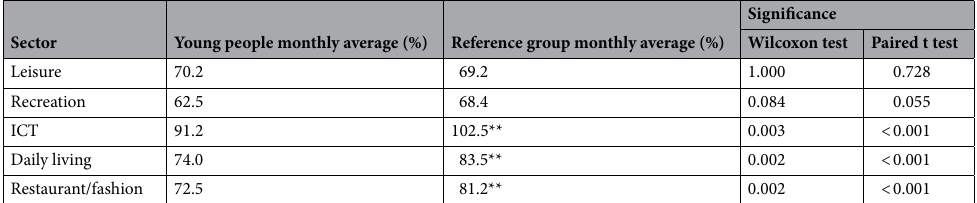
Table 5. Credit card use intensity average and statistical test result by sector and group. Here * is based on the non-parametric Wilcoxon test result, and is indicated at a significantly higher monthly average (**p <